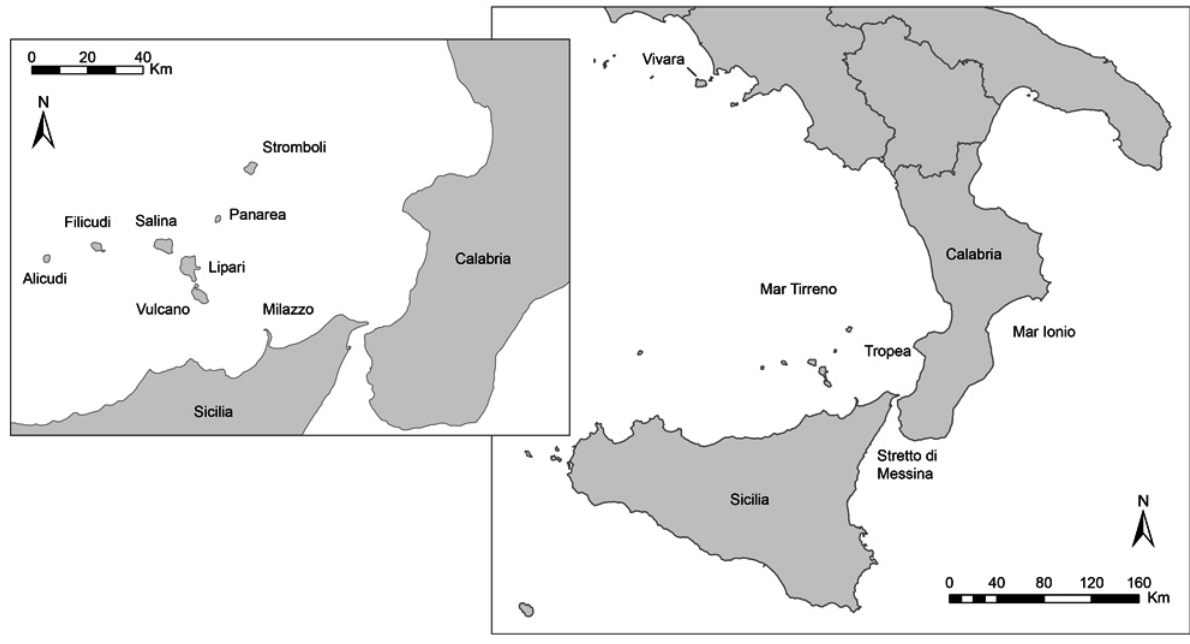
Figure 1: Localization of Aeolian archipelago in southern Tyrrhenian